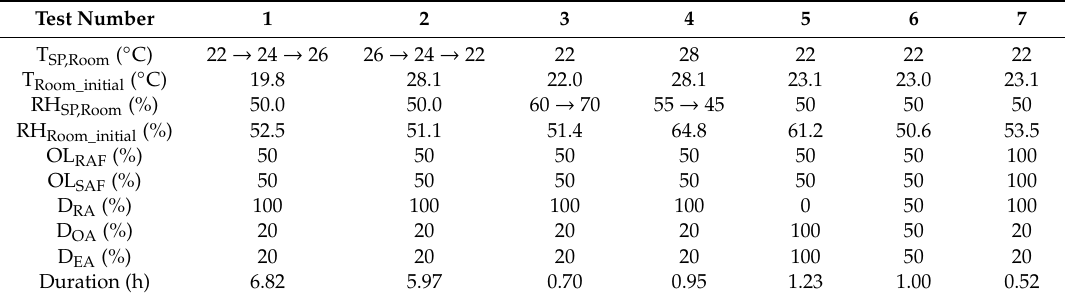
Table 6. Boundary conditions of experimental tests.